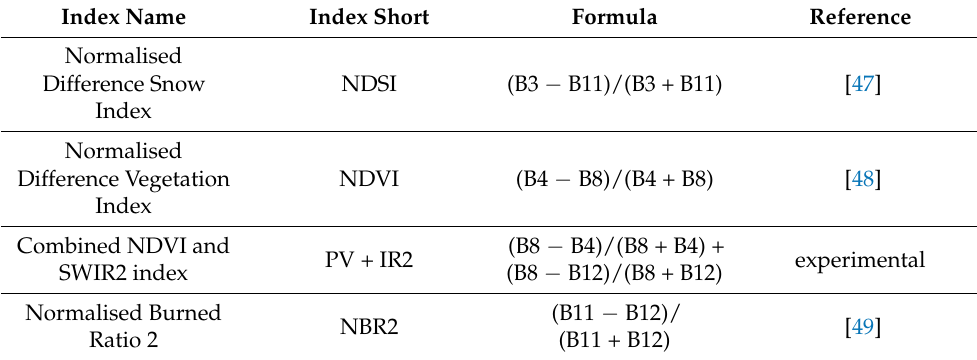
Table 1. Spectral indices used by the SCMaP in this